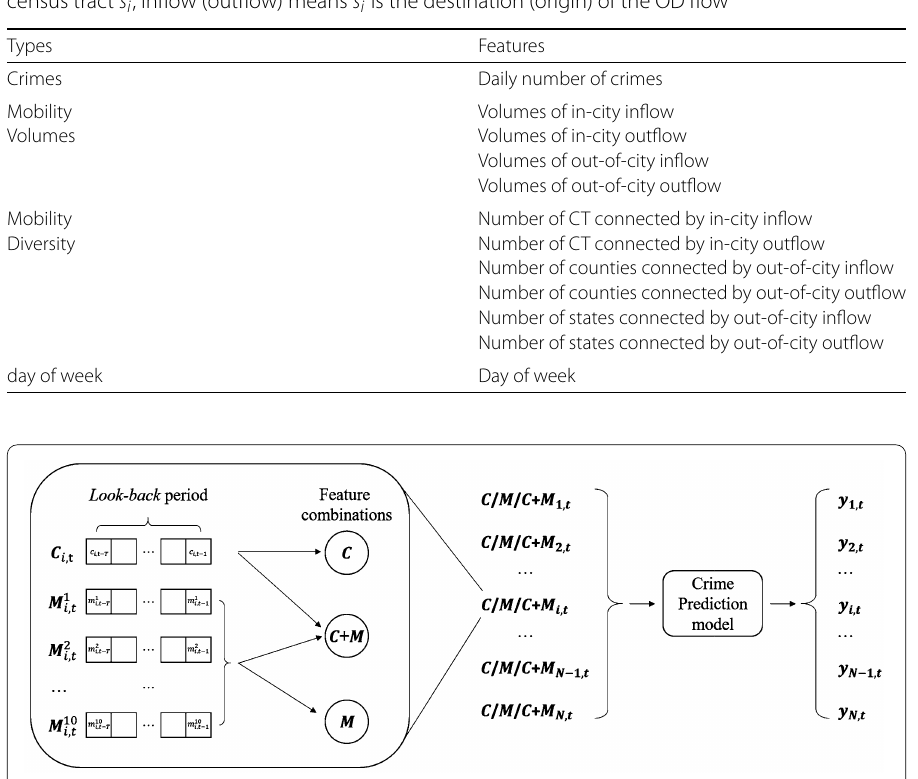
Table 4 Complete list of predictive (input) features for short-term crime prediction models. For census tract s i , inflow (outflow) means s i is the destination (origin) of the OD flow